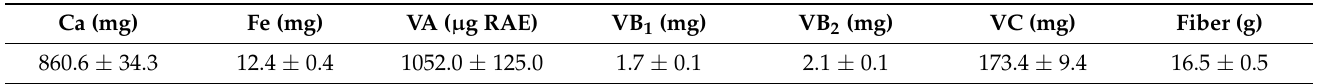
Table 3. Mean values of micronutrient intake.